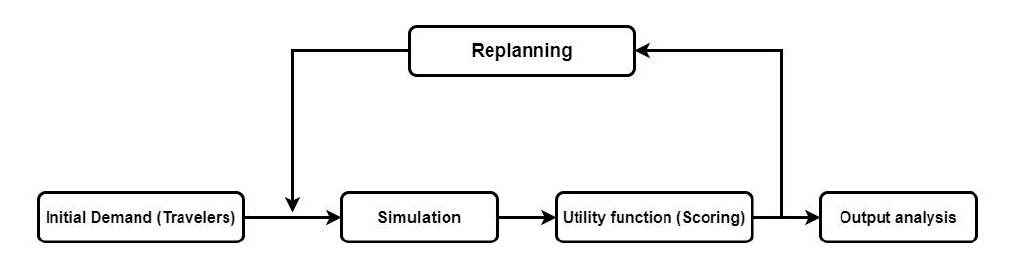
Figure 2. MATSim Figure 2. MATSim loop.